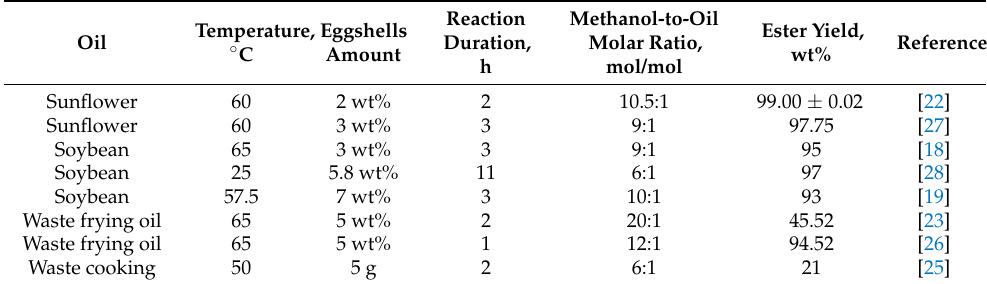
Table 5. A comparison of the optimum conditions for biodiesel production when eggshells are used as a heterogeneous